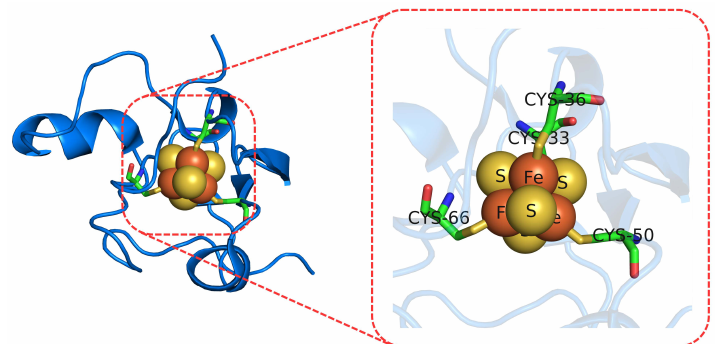
Figure 3. Fe 4 S 4 cluster ( right ) found in high-potential iron–sulfur proteins I from E. Halophila ( left